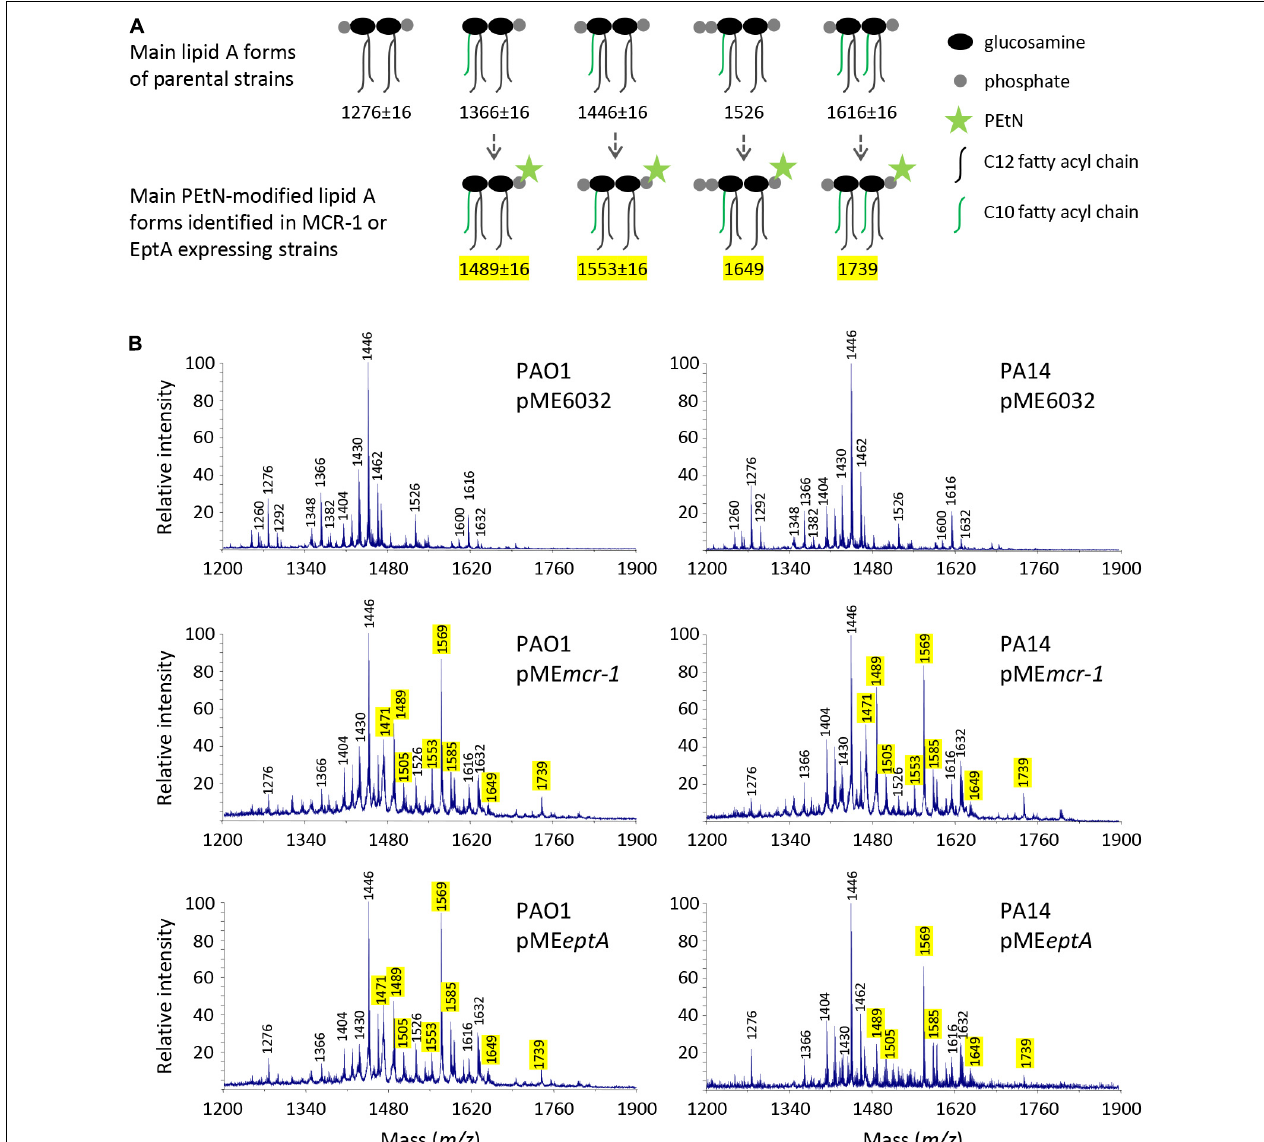
FIGURE 1 | Effect of MCR-1 or EptA expression on lipid A in P. aeruginosa PAO1 and PA14. (A) Cartoons showing the relevant lipid A forms identified by mass spectrometry. (B) MALDI-TOF spectra of lipid A extracted from cells cultured in the presence of 0.5 mM IPTG. Spectra were obtained in the ion negative mode, so m/z values correspond to (molecular mass – 1)/1. m/z = 1276, diphosphorylated tetra-acylated lipid A; m/z = 1366, monophosphorylated penta-acylated lipid A; m/z = 1446, diphosphorylated penta-acylated lipid A; m/z = 1526, triphosphorylated penta-acylated lipid A; and m/z = 1616, diphosphorylated hexa-acylated lipid A. m/z + 123 indicates the addition of a PEtN group, while m/z ± 16 indicates lipid A forms that vary for the presence/absence of a hydroxyl group in the secondary C12 acyl chains (Nowicki et al., 2015; Liu et al., 2017; Lo Sciuto et al., 2019). The peak at m/z = 1471 likely corresponds to the phosphoethanolaminated form of a still non-identified lipid A species at m/z = 1348 (Ghirga et al., 2020; Lo Sciuto et al., 2020). The m/z values of peaks corresponding to the phosphoethanolaminated lipid A forms here identified are highlighted in yellow.